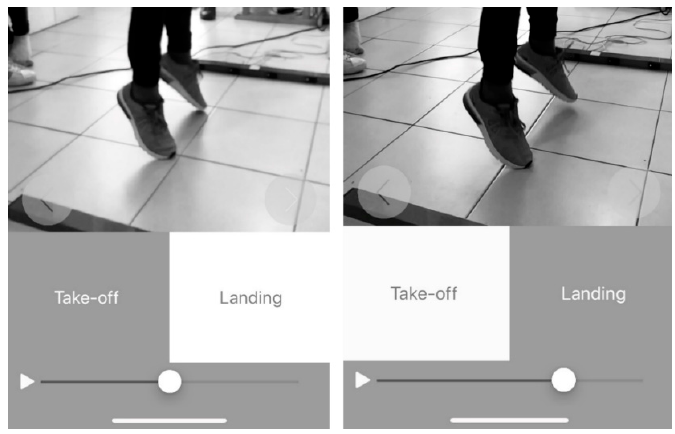
Figure 1. Take-off and landing phase frames on the My Jump 2 app. Figure 1. Take-o ff and landing phase frames on the My Jump 2